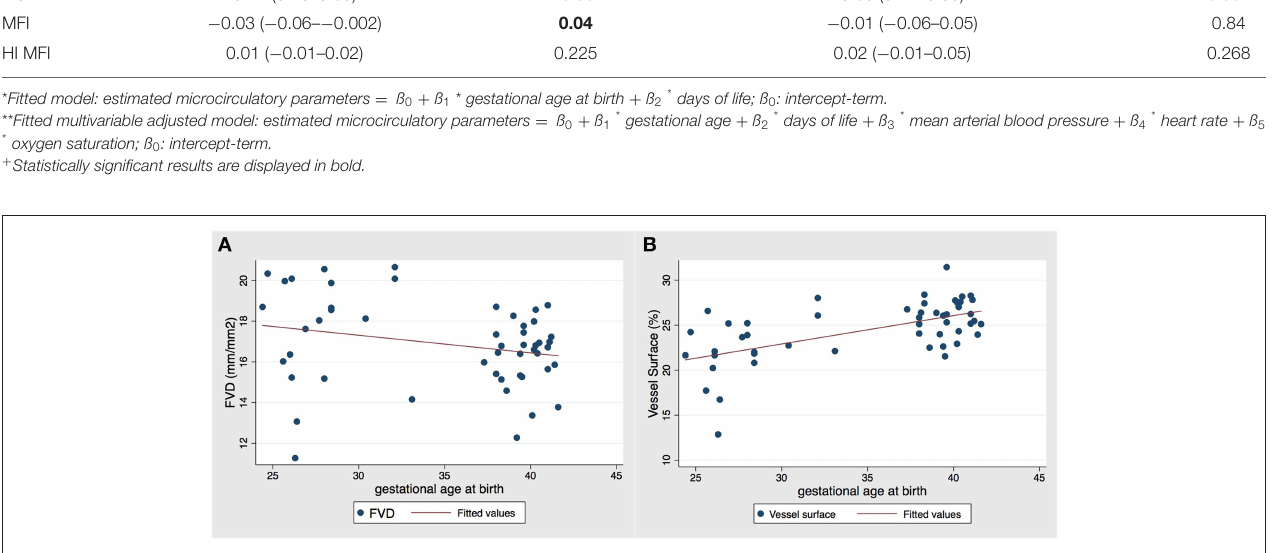
FIGURE 2 | Two-way scatter plot of obtained values of (A) FVD and (B) VS against gestational age at birth with fitted linear regression line in red (adjusted for days of life). There was no statistically significant association between FVD and gestational age, but there was a statistically significant linear increase in vessel surface with increasing gestational age ( p =